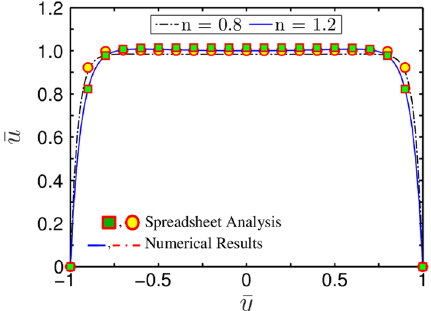
Figure 9. Plots depict velocity profile for different values of n at z = 0 . The other parameters are taken as κ = 20 , and Ŵ = 0 . The MATLAB solutions are represented by solid lines, whereas the spreadsheet analysis tool-derived solutions are shown by markers.